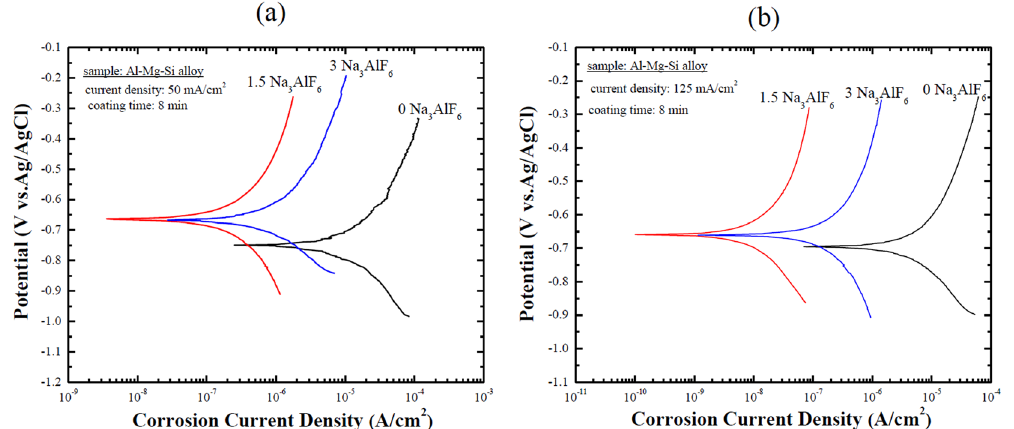
Figure 5. Potentiodynamic polarization curves recorded in 3.5 wt.% NaCl solution of the coatings formed on an Al-Mg-Si alloy by PEO at ( a ) 50 mA/cm 2 and ( b ) 125 mA/cm 2 using electrolytes containing different concentrations of Na 3 AlF 6 . The potentiodynamic polarization curves were recorded at a scan rate of 1 mV/s from − 0.25 V to + 0.4 V with respect to the open circuit potential.